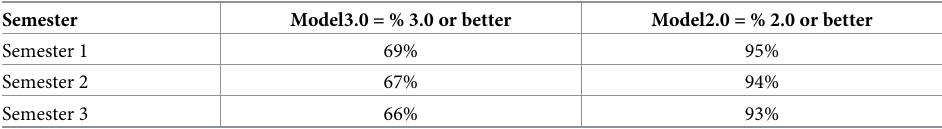
Table 1. Percentage success over